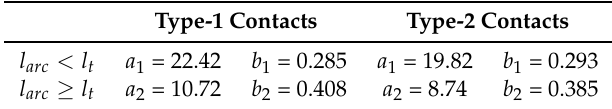
Table 3. Fit values of constants in the proposed arc voltage model.